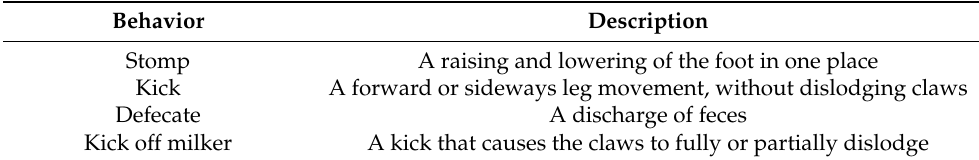
Table 2. Ethogram of behaviors recorded during milking adapted from Eicher et al. [22]. Behavior Description Stomp A raising and lowering of the foot in one place Kick A forward or sideways leg movement, without dislodging claws Defecate A discharge of feces Kick off milker A kick that causes the claws to fully or partially